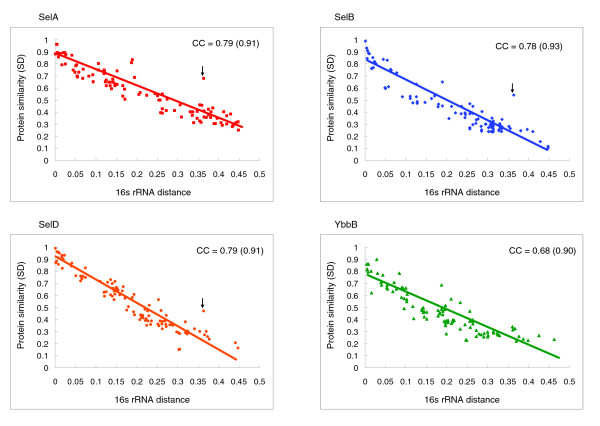
Evolutionary divergence of components of two selenium utilization traits extracted from the datasets identified in this work. Each graph contains 100 randomly selected organism pairs (points). The protein similarity (sequence divergence [SD]) of each component usually changes proportionally with the phylogenetic distance. Correlation coefficient (CC) is shown (number in the parentheses shows an updated CC after removing horizontal gene transfer [HGT] events). Points that are located above and distant from the reference line suggest potential HGT events. A reported HGT organism pair (Photobacterium profundum and Treponema denticola) of the Sec-decoding trait is shown with arrows for reference.